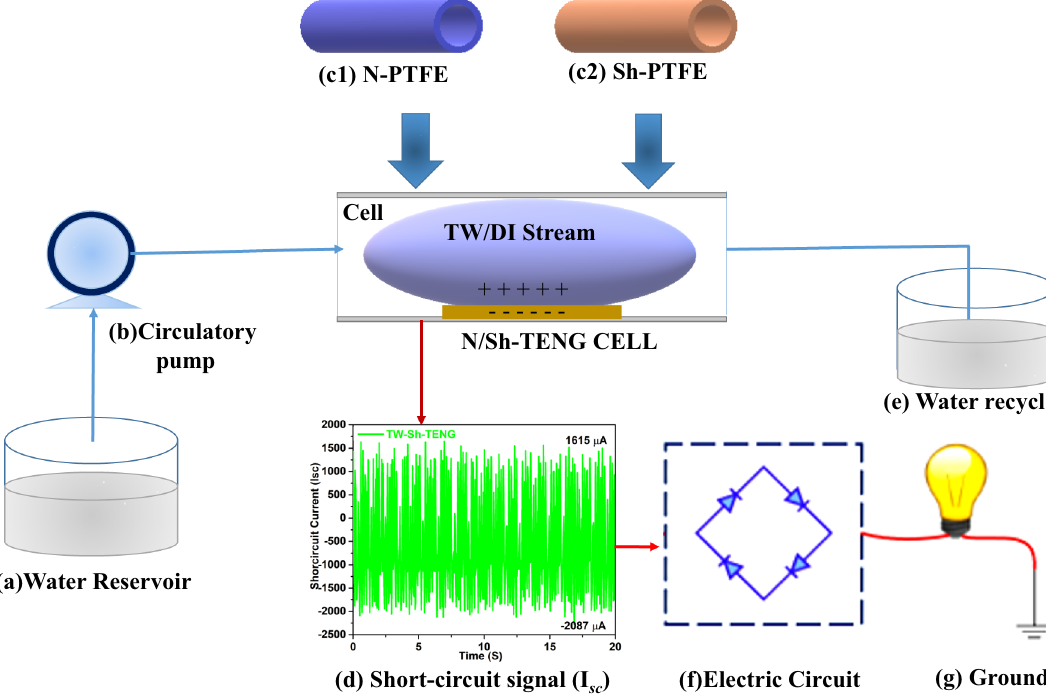
Figure 1. Schematic representation of the Sh-TENG, and N-TENG